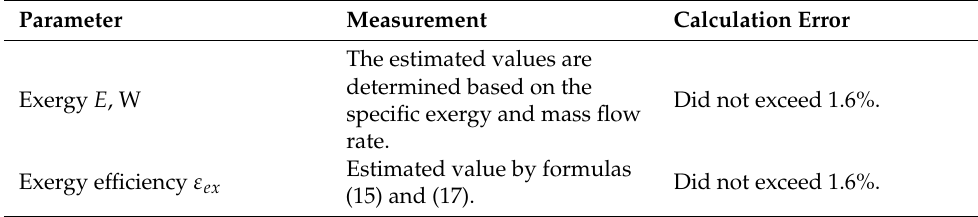
Did not exceed 1.6%.